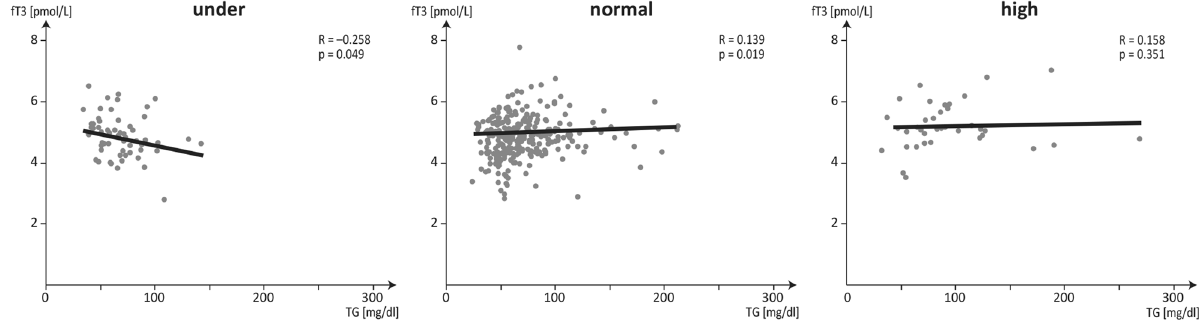
Figure 1. Changing correlations between fT3 and TG serum concentrations in healthy young underweight, normal-weight and overweight